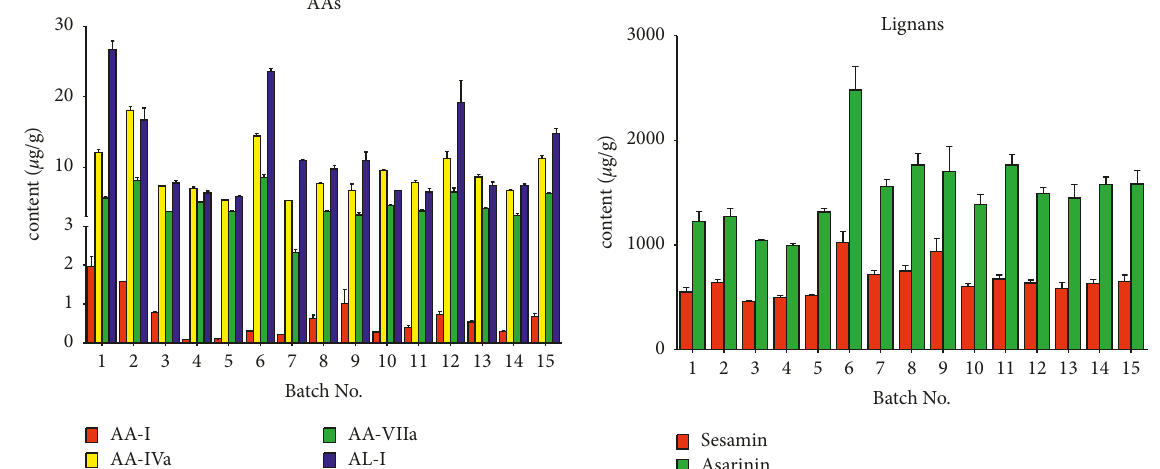
Figure 3: Content of AAs and lignans in 15 batches of crude drugs samples (mean ± SD, n �